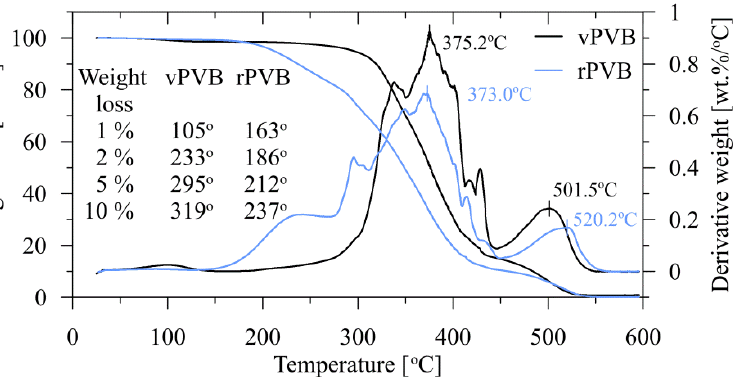
Figure 11. The results of thermogravimetric analysis and derivative thermogravimetric analysis for vPVB and rPVB.